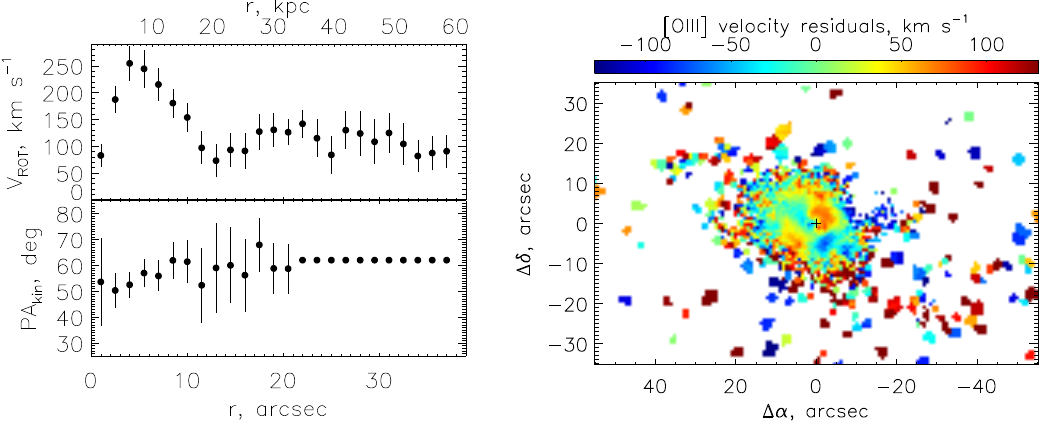
Figure 5. Radial variations of the tilted-ring model parameters ( left panel ): the circular rotation velocity ( top ) and the kinematic position angle ( bottom ). The right panel shows residual velocity field after subtraction of the disk circular rotation